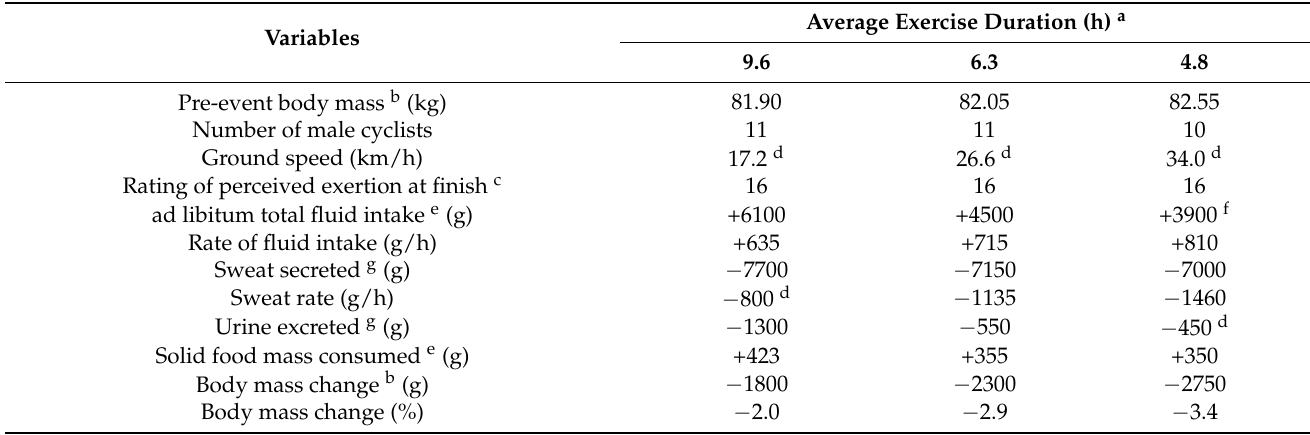
Table 2. Characteristics of three groups of cyclists who completed a 164 km summer road cycling event in 4.8–9.6 h (modified from [15]). No drinking instructions or experimental interventions were